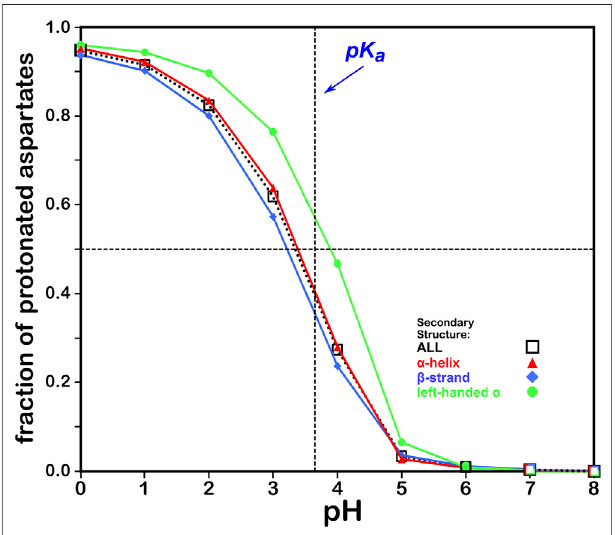
FIGURE 5 | Titration curves of GLU residues by secondary structure. The native pK a for glutamic acid is